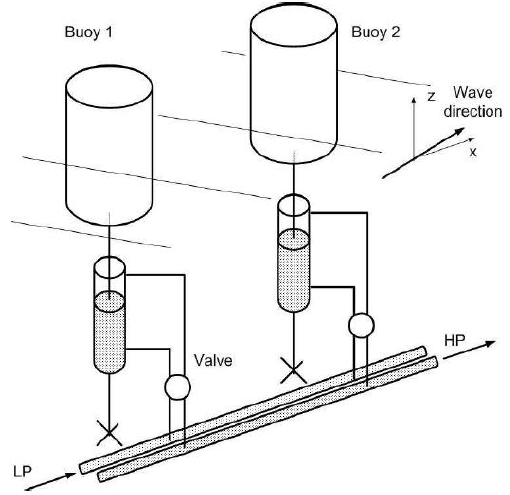
Figure 7. Schematic of the two-buoys studied by [76] to check the effect of the interactions on the power capture.